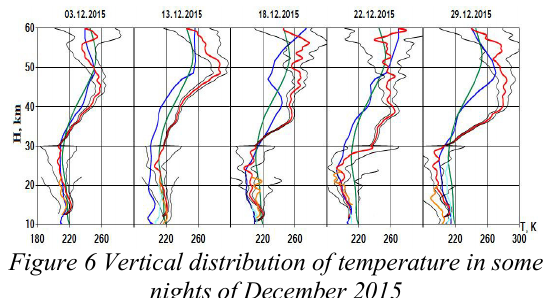
Figure 6 Vertical distribution of temperature in some nights of December 2015